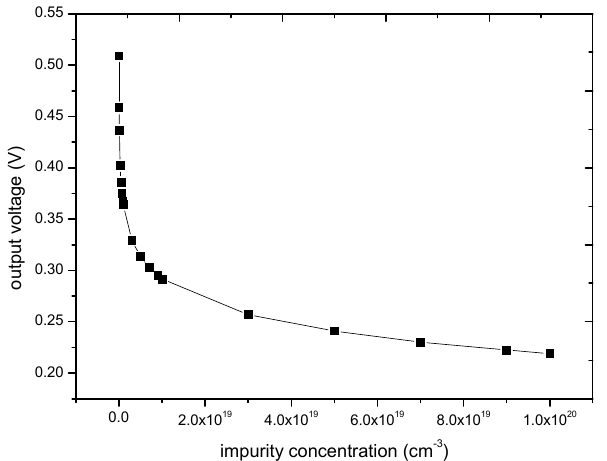
Figure 4. The relation between output voltage and doping concentration.